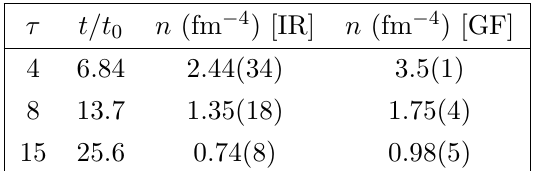
Table 3 . Comparisons of instanton densities obtained by applying the localization technique (third column) and the Green’s function running method (fourth column), after the Gradient (cid:13)ow for three representative times. The errors here quoted incorporate, and are basically dominated by, some systematic uncertainties in the IR case (see text), but only statistical for the GF